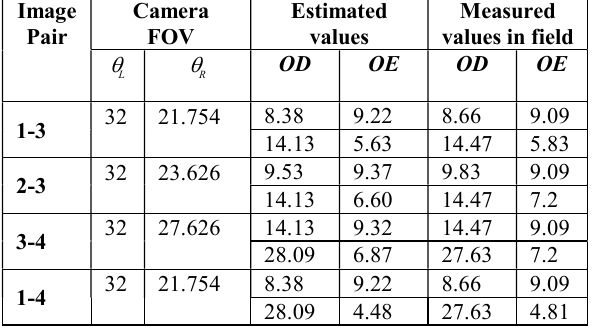
Table 2. Theoritical Values and Field Measurements for 90°